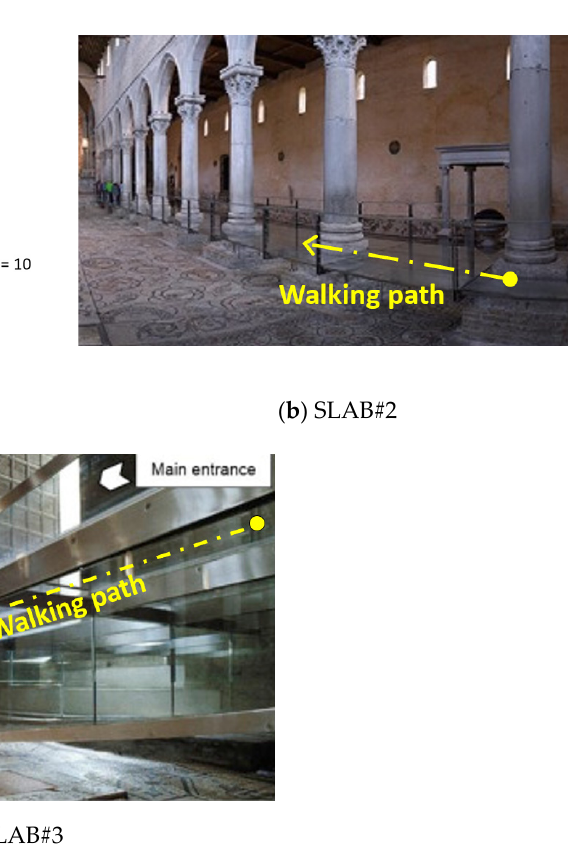
Figure 5. Experimental analysis on ( a ) rigid or ( b , c ) flexible substrates. (Figures ( a , c ) reproduced with permission from [18] under the terms and conditions of CC ‐ BY license agreement). with permission from [18] under the terms and conditions of CC-BY license Table 2. Summary of structural features for normal walking experimental measurements.